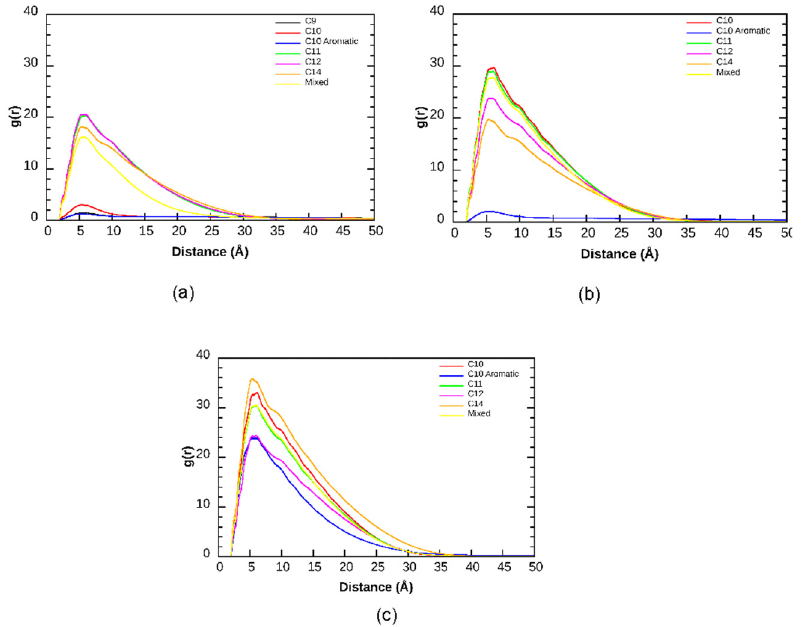
Figure 7. Radial distribution function quantifying the distribution of NAs around each single NA center of mass in ( a ) pure water, ( b ) low salinity solution (NaCl 35 g/L), and ( c ) high salinity solution (NaCl 90